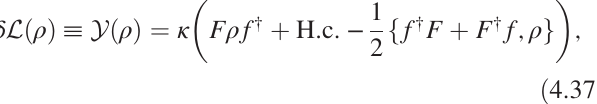
, the nonzero edg ≥ Δ edg dg